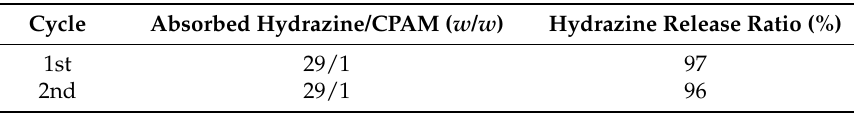
Figure 4 . Releasing of hydrazine from CPAM-based hydrazine gel (CPAM/hydrazine = 1/29 ( w / w )) by N 2 flow. Table 3 . Absorption of hydrazine with CPAM and releasing of hydrazine from CPAM-based hydrazine gel by N 2 gas flow.